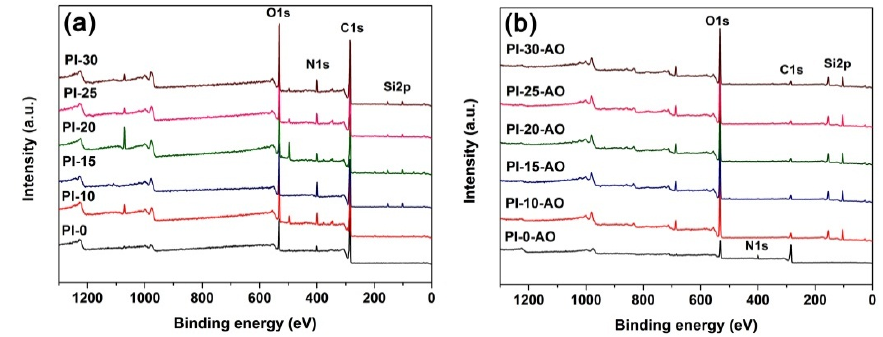
Figure 11. XPS spectra of PI films. ( a ) pristine samples; ( b ) AO ‐ exposed samples. Table 4. XPS results for the unexposed and exposed POSS ‐ PI films.